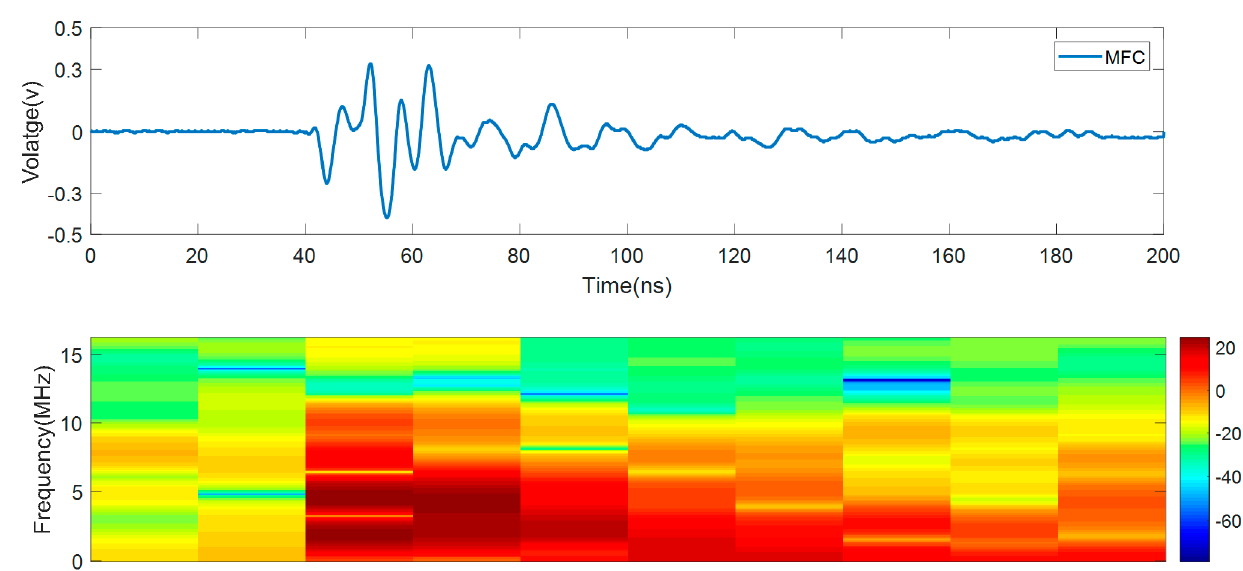
Figure 12. Spectrogram of the PD acoustic signal captured by the MFC